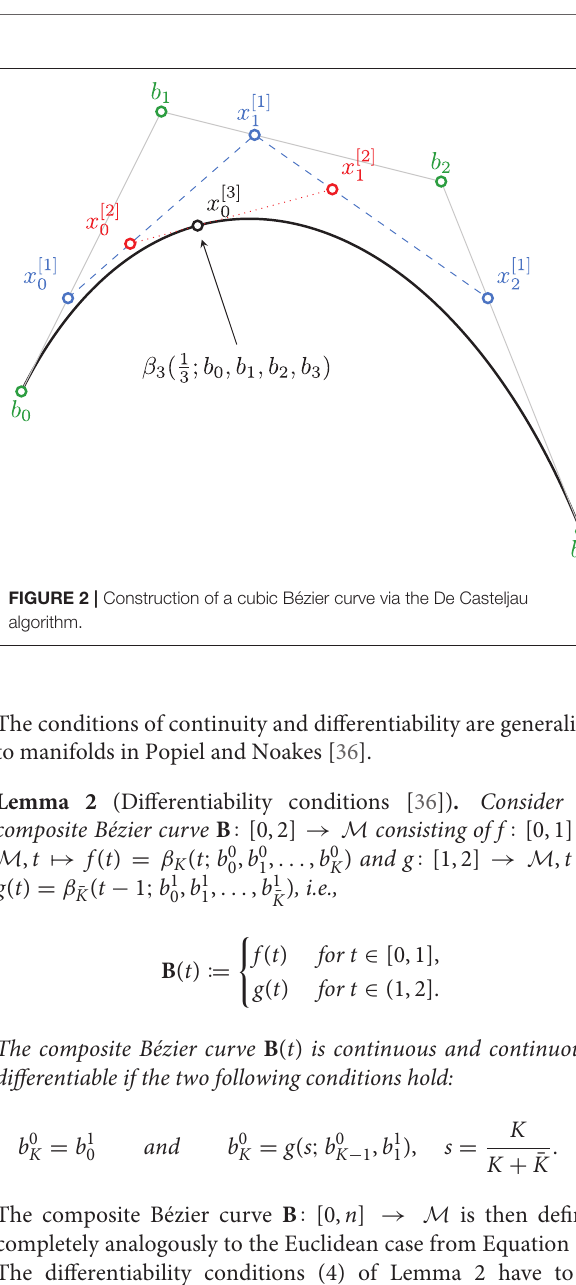
Figure 1 for an example on M Figure 3 for an example on M